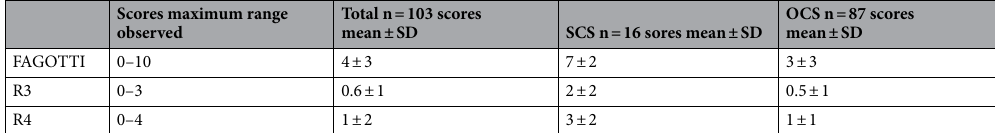
Table 3. Descriptive analysis of the total scores obtained with each model. SD, standard